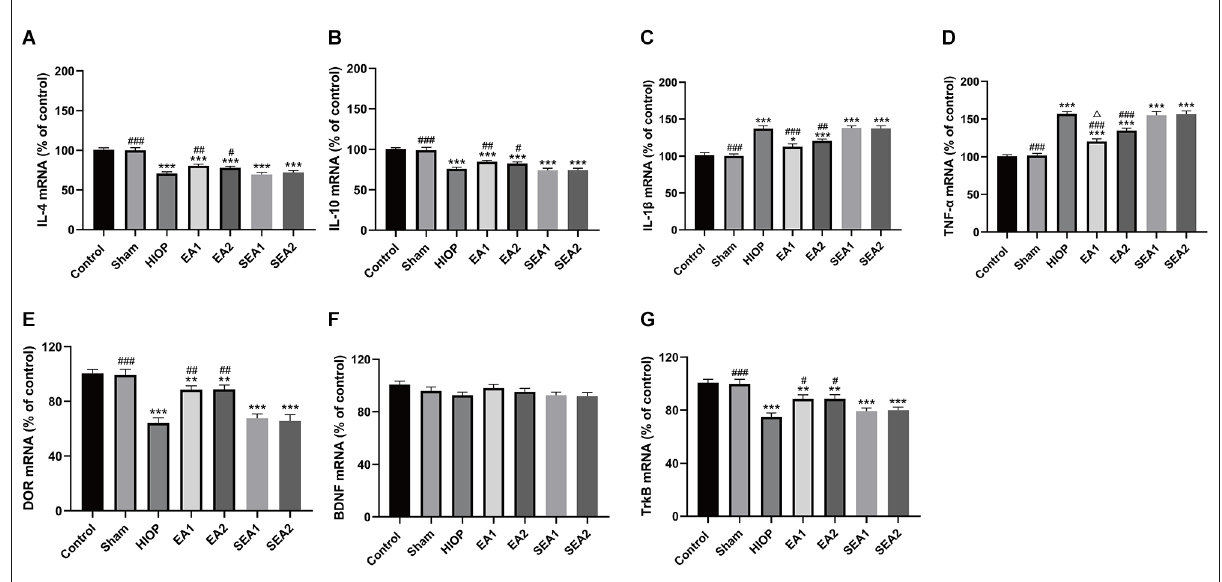
FIGURE6 EA can activate DOR and elevate DOR and TrkB expression to reduce the inflammatory response after RIRI for 3 days. (A–D) The mRNA expression levels of proinflammatory cytokines (TNF- α and IL-1 β ) and anti-inflammatory cytokines (IL-4 and IL-10) were evaluated by RT–qPCR at 72 h of reperfusion following 1 h of retinal ischemia. (E–G) The mRNA expression levels of DOR, BDNF, and TrkB were evaluated by RT–qPCR at 72 h of reperfusion following 1 h of retinal ischemia. The data are expressed as the mean ± SEM (* P < 0.05, ** P < 0.01, *** P < 0.001 vs. the